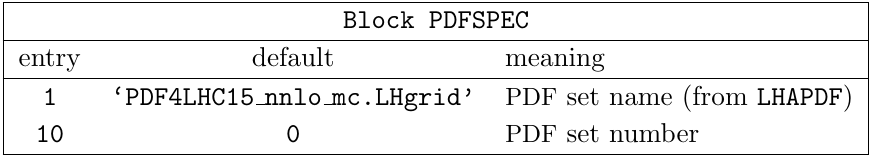
Table 5 . Choosing a PDF set.